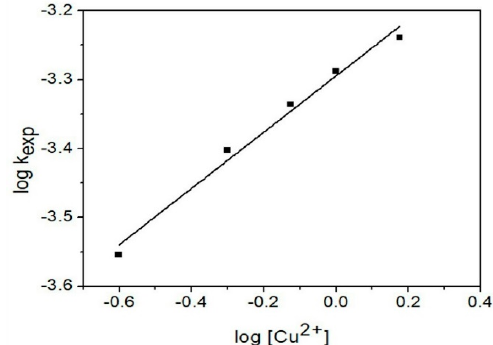
Figure 10. k exp dependence in function of [Cu 2+ ]. Reaction order n = 0.4. (V = 0.5 L, 40 g ∙ L − 1 Mineral, PO 2 = 1 atm, pH = 10, leaching time = 240 min, [S 2 O 32 − ] = 0.16 mol ∙ L − 1 , 298 K (25 °C), RPM = 750 min − 1 ).